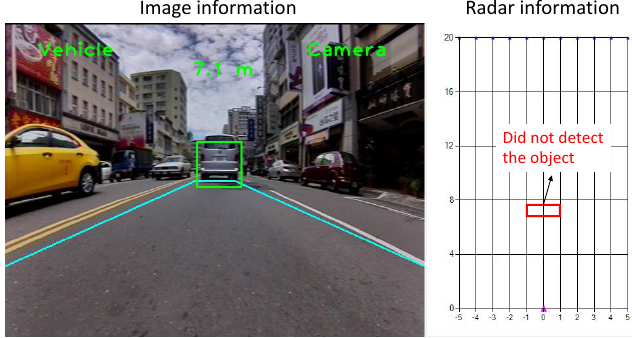
Energies 2019 , 12 , x